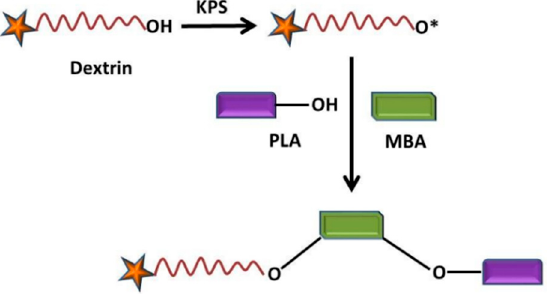
Figure 12. Process for obtaining PLA-based hydrogel by free radical polymerization using MBA as a crosslinking agent.